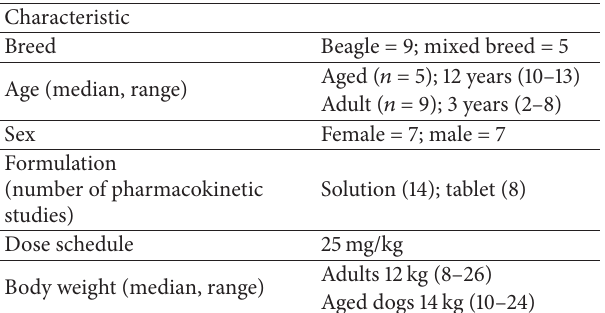
Table 1: Characteristics and treatment of the animals. Characteristic Breed Beagle = 9; mixed breed = 5 Age (median, range)